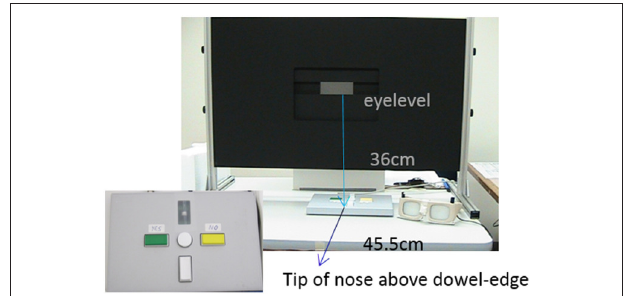
FIGURE 1 | Setting for the aperture task. Participants were seated centrally in front of the apparatus, with the eyes being on the level of the opening and their tip of the nose being positioned vertically in line with the edge of a dowel fastened below the table (about 45.5cm from the apparatus). Manual adjustments of the aperture were possible using a belt mechanism in the back of the apparatus; dimension specifications allowed for measuring millimeter increments. Participants wore plato-goggles (here: opaque) throughout the experiment to control for visual feedback and to allow for RT-measurements. Goggles were opened for the start of each trial. The rightwards shifted positioning of the response box reflects an affordance judgment block for active right hand